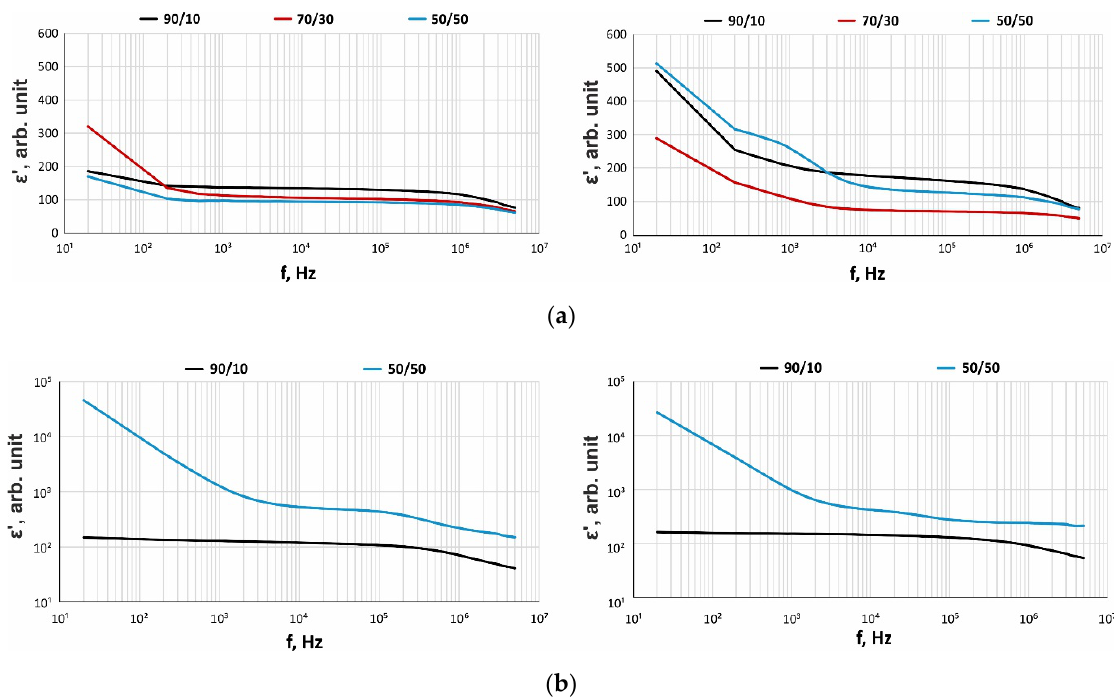
Figure 3. Spectra of the real part of CDP for the drill cuttings from 960 (left) and 970 (right) m depths, saturated with water–oil mixtures: ( a ) based on oil C; ( b ) based on oil E.